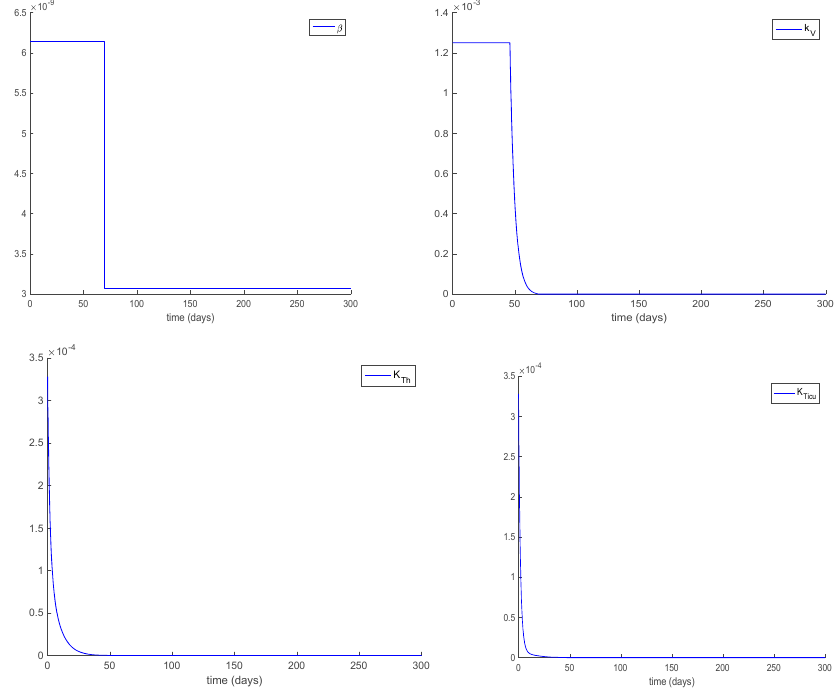
Figure 6. Control actions when Programme 2 is employed and β is a control variable.